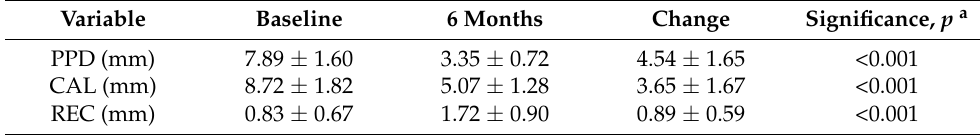
Table 2. Clinical outcomes at baseline and 6 months after treatment ( n = 27). Variable Baseline 6 Months Change Significance, p a